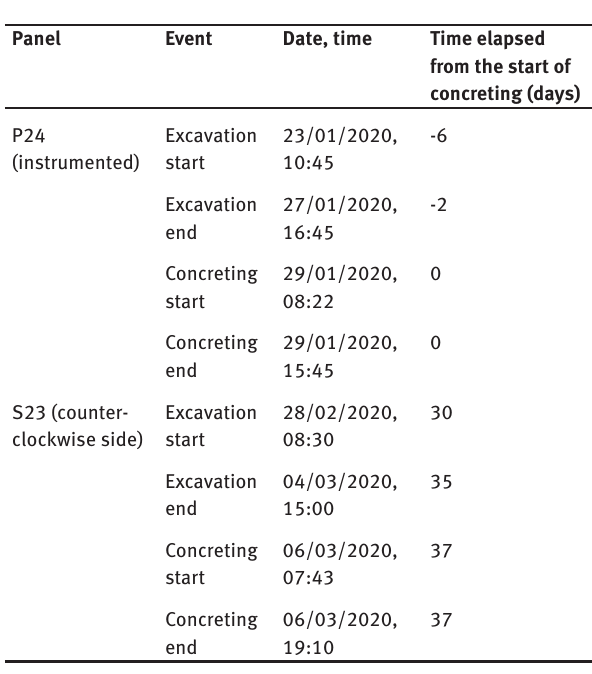
Table 2: Important timeline events for the instrumented panel P24.